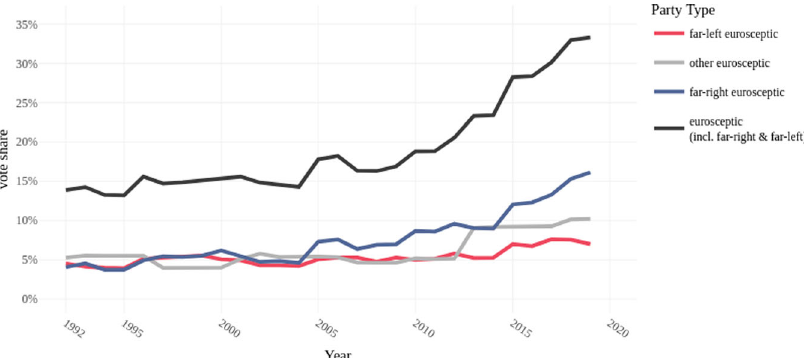
Fig. 1 Share of Eurosceptic, far-right and far-left parties votes weighted by population size. Note: Data from ParlGov, European Countries; Classi fi cations The PopuList, link: